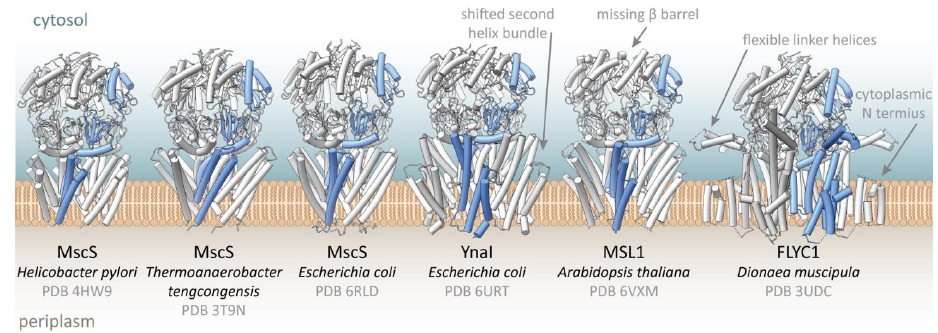
Figure 4. Structures of MscS homologues. The structural organisations of different MscS-like channels are shown in light grey, highlighting both similarities and differences between the channels. The structures are shown in the same size and orientation, and the same subunit of each channel is emphasised in blue. Besides, their approximate position in the membrane (brown), as suggested from cryo-EM structures, is considered in this figure. Structures of MscS were so far obtained from three different organisms, all exhibiting a highly similar architecture. Additionally, several structures of the E. coli paralogue YnaI were obtained, as well as structures from the plant channels MSL1 and FLYC1. The most obvious peculiarities of the larger homologues are indicated by grey arrows. Details and references for the depicted models are listed in Table 1.